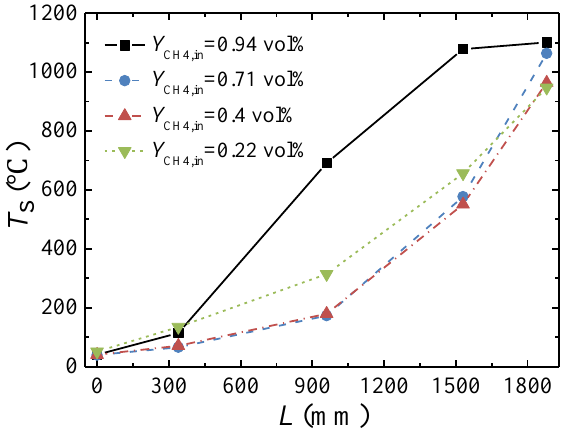
Figure 12. Solid temperature ( T s ) profile of bed 1 along the length ( L ) of the TFRR for different feed methane concentrations ( Y CH4,in ) at the end of the cycle when F in ≈ 105 × 10 3 Nm 3 /h and t c = 300 s.